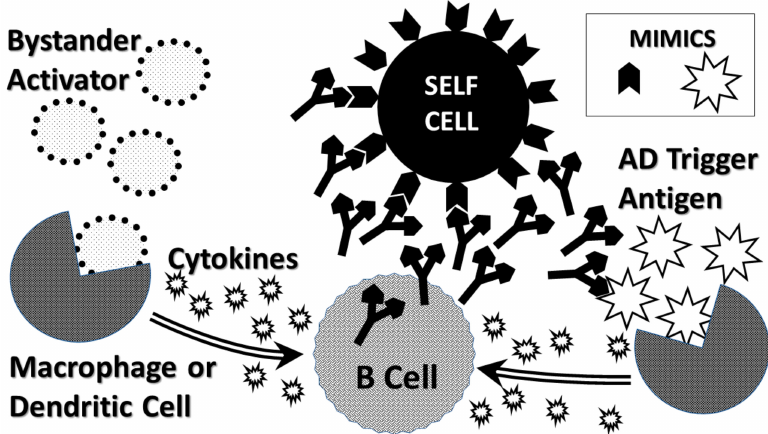
Figure 5. Schematic diagram of the bystander activation theory (BAT). BAT is the only current theory that explicitly integrates innate immunity into its explanation of pathogenesis. It assumes that there are two, independent sources of immunologic activation underlying initiation of any AD. One source of activation is a bystander infection or antigenic challenge that activates macrophages or dendritic cells to produce large quantities of cytokines. These cytokines draw additional monocytes to the area and stimulate any resulting T or B cell activity. Meanwhile, a second antigenic challenge, which will initiate the autoimmune disease (AD) occurs simultaneously. Once again, macrophages or dendritic cells process this AD trigger, initiating an appropriate T or B cell response. BAT is usually presented as an adjunct to MMT (Figure 2), but there is no reason that it cannot be compatible with any other AD theory (Figures 3 and 4). The important aspect of BAT is that the simultaneous cytokine production by the AD triggering process along with the bystander stimulation results in hyper-activation of the B or T-cell mediated immune response to the AD trigger and, in consequence, overcomes tolerance to the host’s own